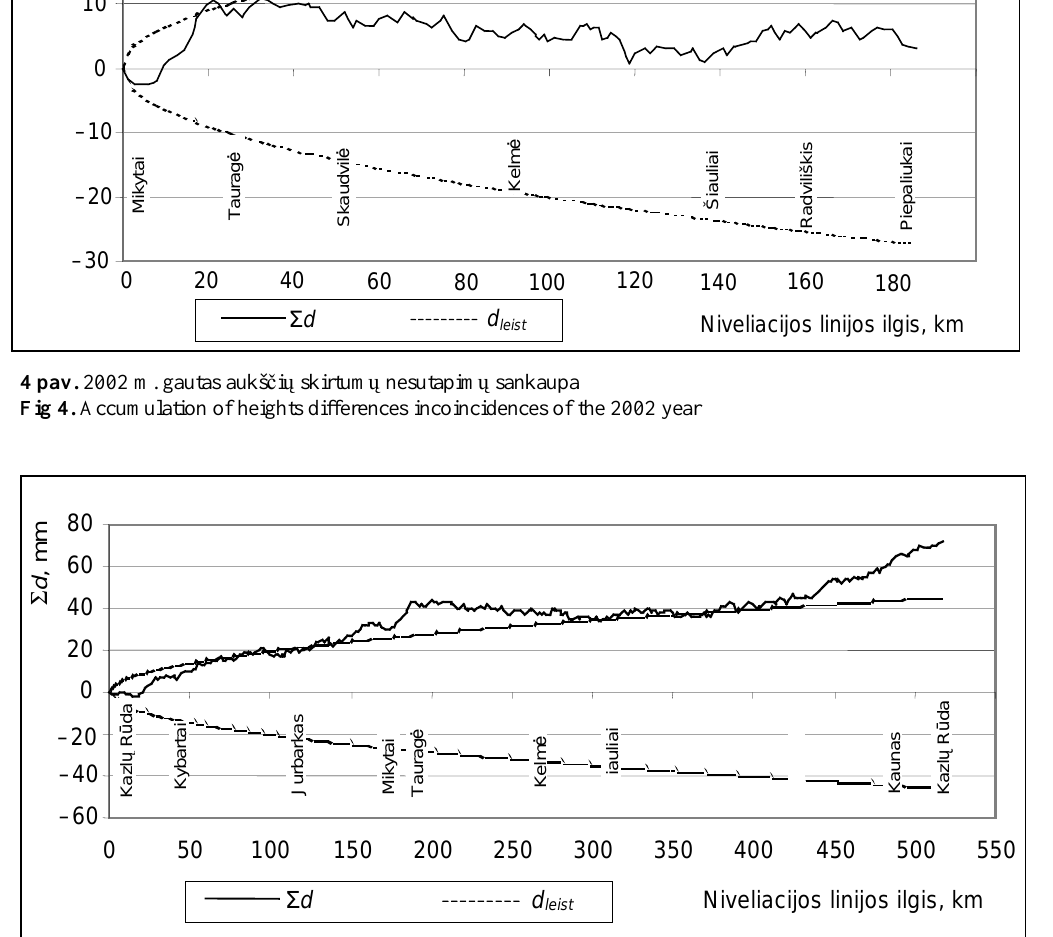
Fig 5. Accumulation of heights differences incoincidences of the second